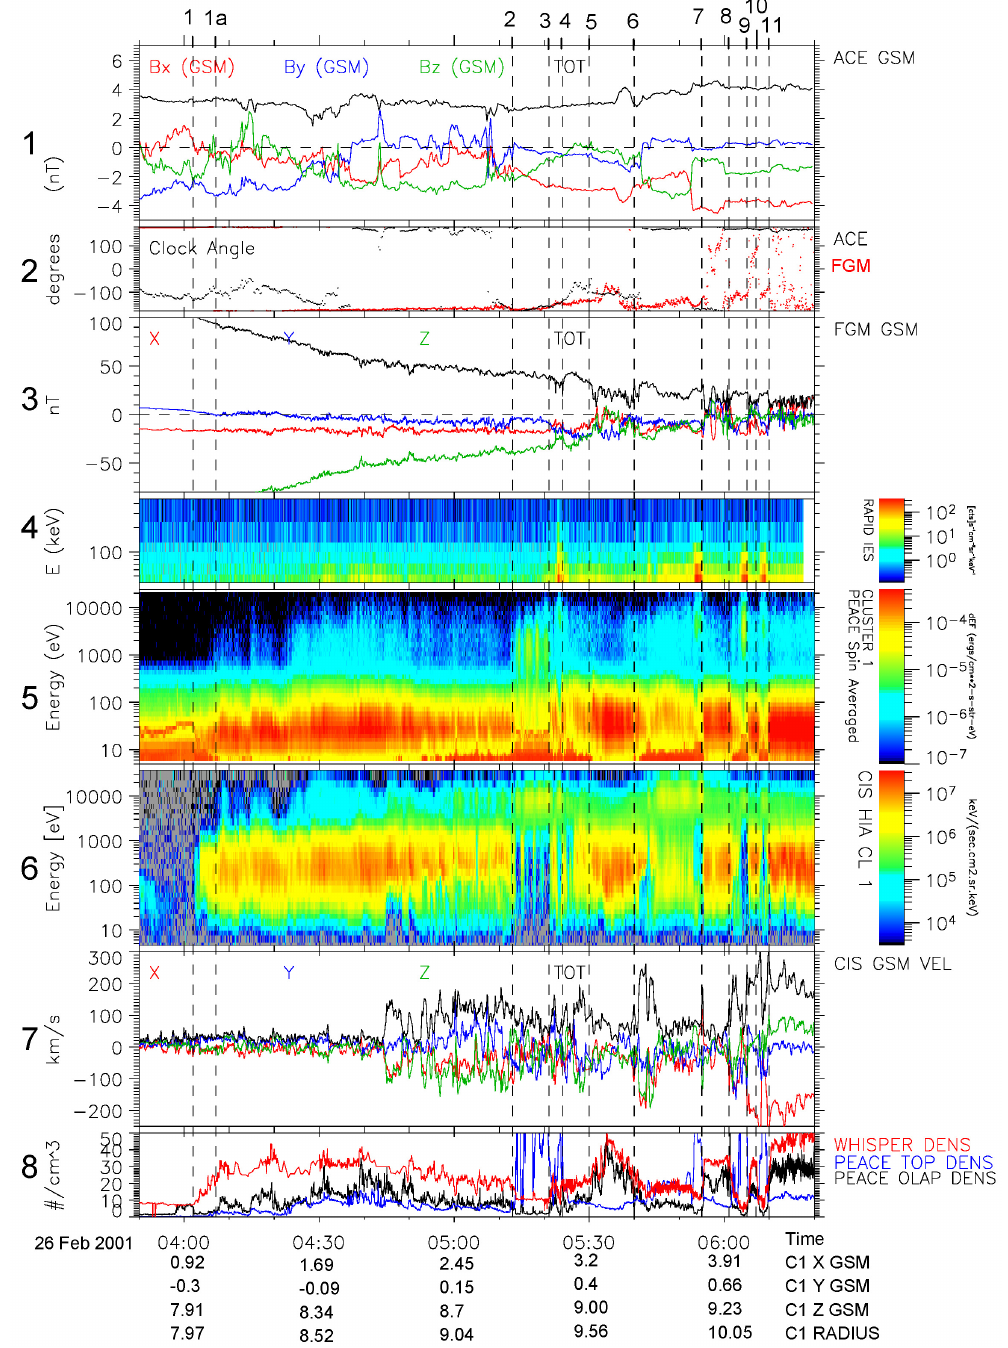
Fig. 1. We note that all Cluster data is presented in 4-s spin resolution, unless otherwise stated. Panel 1 shows ACE magnetic field data in the GSM coordinate frame, x, y, z and magnitude. ACE is at position ∼ (232, − 40, − 5) R E GSM at this time. MFE values are Level 2 16-s resolution with a 85-min lag applied. Panel 2 shows a comparison of ACE (black dots) and Cluster (red dots) magnetic field clock angles, where clock angle is arctan (B Y /B Z ) . Panel 3 shows FGM magnetic field data from Cluster 1 in GSM coordinates. Panels 4–6 show RAPID IES electron, PEACE electron and CIS HIA ion data in the form of energy–time spectrograms. Flux units are #/cm 2 ssrkeV, ergs/cm 2 ssreV and keV/cm 2 ssrkeV, respectively. Panel 7 shows CIS ion velocity in GSM coordinates. Finally, Panel 8 shows PEACE derived densities (TOP in blue, scaled by 200 and OVERLAP in black) and WHISPER derived densities in red. The dashed, numbered vertical lines represent the boundaries discussed in Table